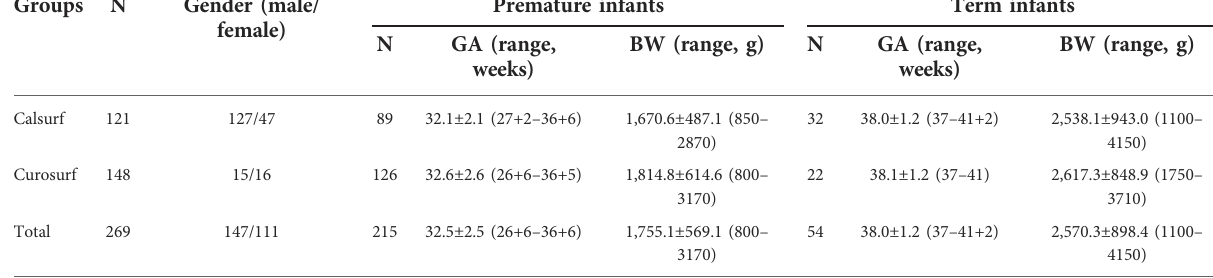
TABLE 1 The demographic data in different